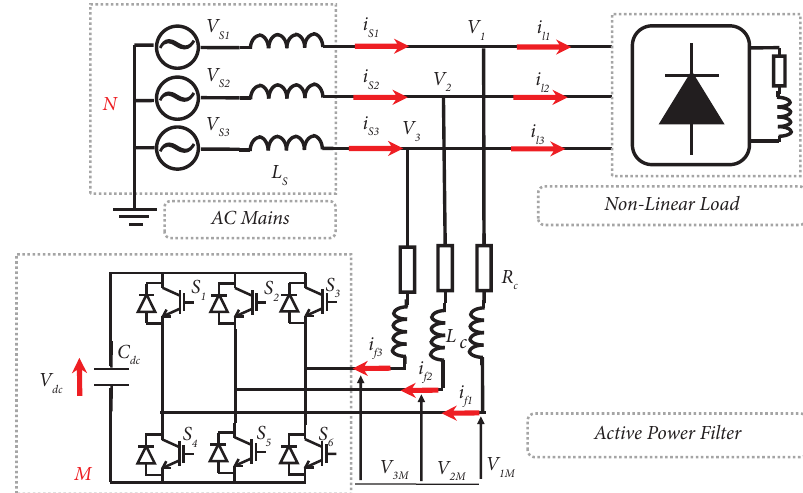
Figure 1: Shunt active power flter